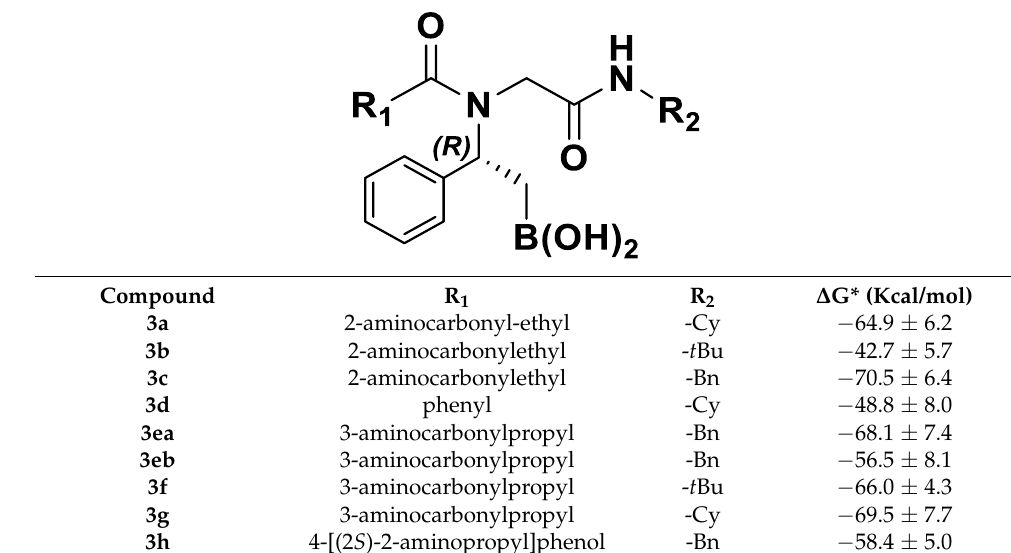
Table 1. Chemical structure and predicted binding free energy values ( ∆ G*) of the most promising β -amido boronic acids.